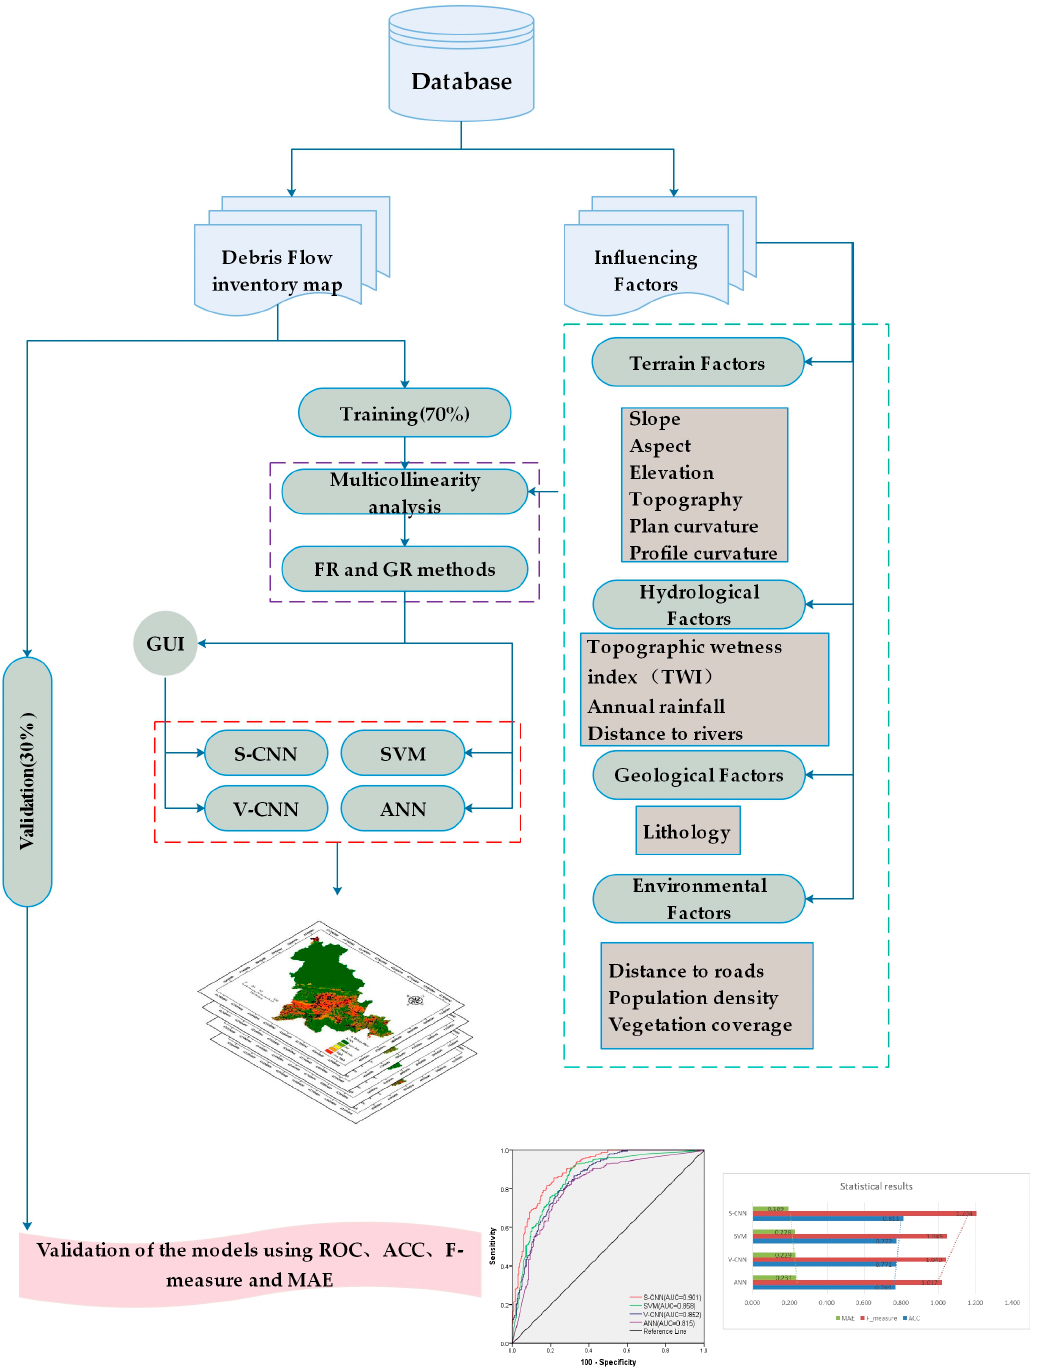
Figure 2. The flowchart of the methodology used in this